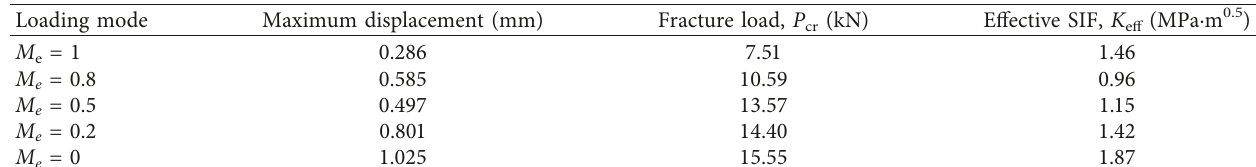
Table 4: Fracture loads and critical effective SIFs at different loading modes.